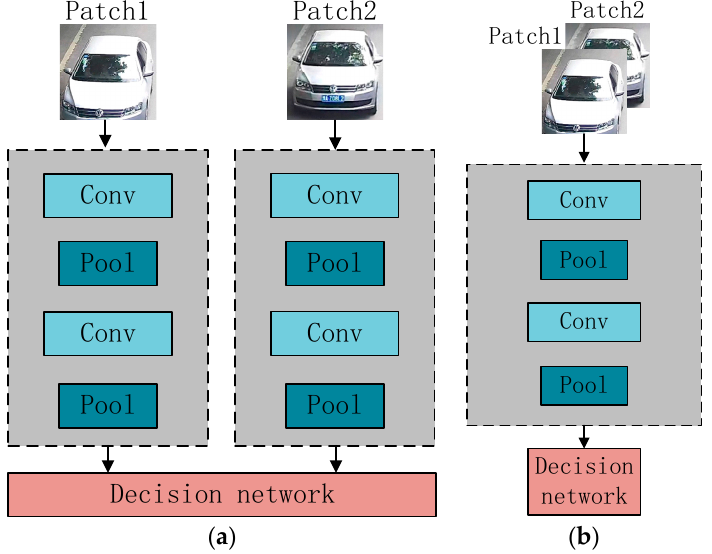
Figure 2. Similarity network. ( a ) Bilinear structure. The two image blocks are input into two branches to generate two features respectively. ( b ) Double channel structure. The fused two blocks are input with the network with shared weights and shared feature maps.